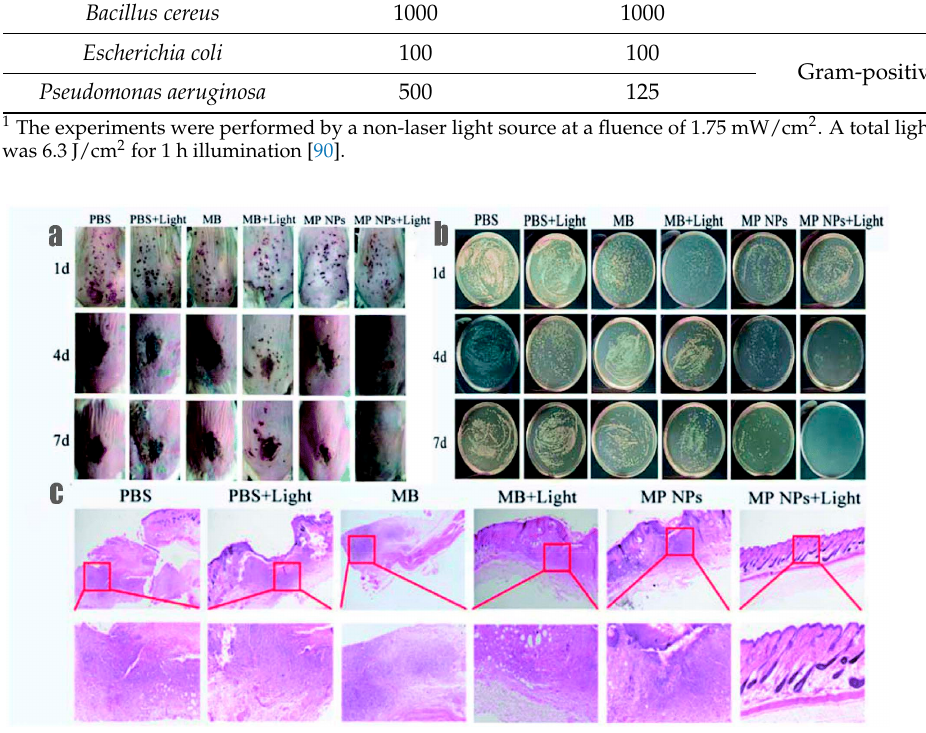
Figure 6. ( a ) Photographs of infected wounds in mice at different timepoints after different treat- ments: PBS, PBS + light, MB, MB + light, MPNPs, and MPNPs + light. ( b ) Photographs of bacterial colonies formation on LB agar plates from the infected wounds after different treatments. ( c ) H&E staining (Hematoxylin and Eosin) of tissue sections of MRSA infected wounds in mice with different treatments. The scale bar is 500 µm [94].